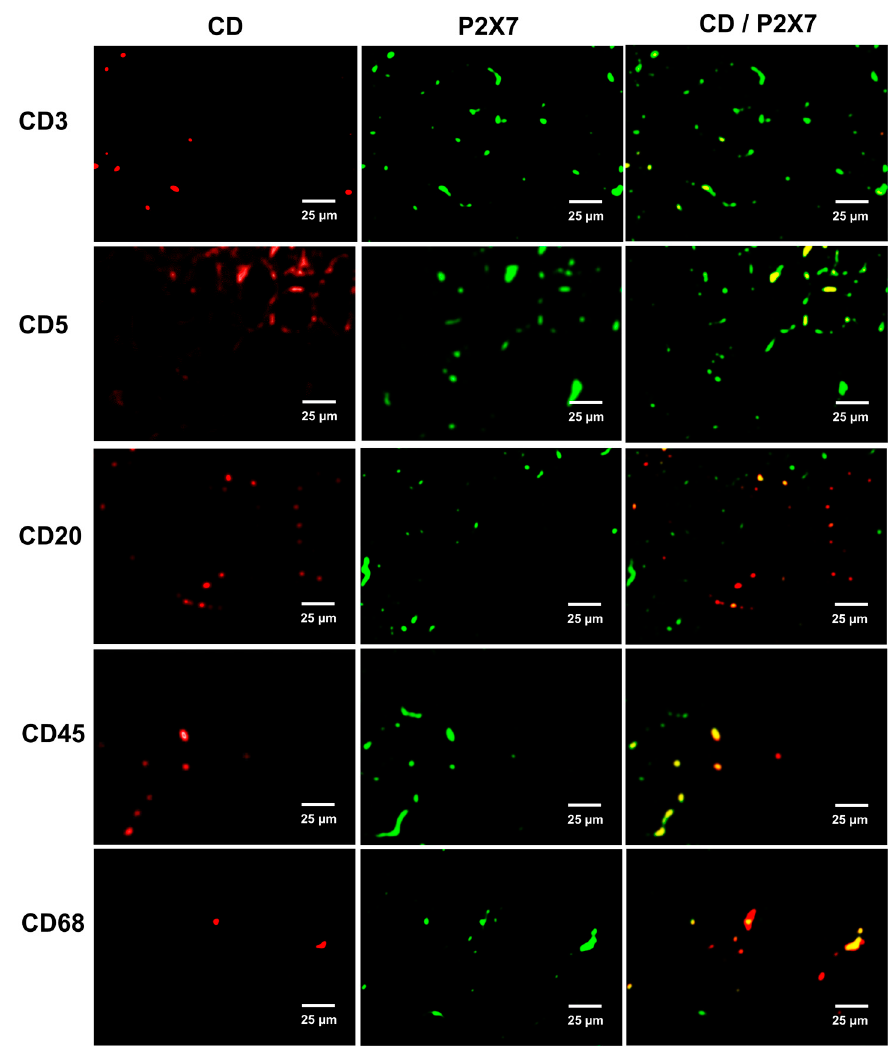
Figure 6. P2X7 receptors (second column) in the infiltrating T cells of Ang II group co-localize with cluster differentiation (CD, first column) antigens in T cells (CD 3 positive cells), B cells (CD5 and CD20 positive cells), macrophages (CD68 positive cells) and leukocyte common antigen CD45, predominantly expressed in T lymphocytes .